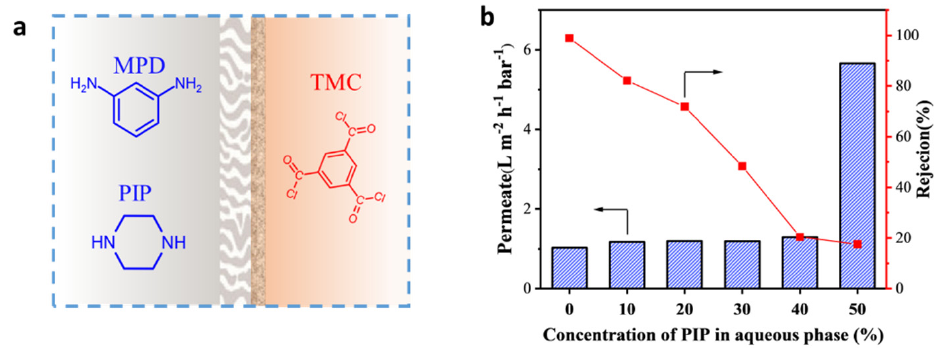
Figure 6. ( a ) Control groups for showing the key point for fabricating an RFRO membrane, where PIP (diamine with flexible aliphatic ring) was added into the aqueous phase for IP. ( b ) Performance of membranes fabricated by adding PIP.